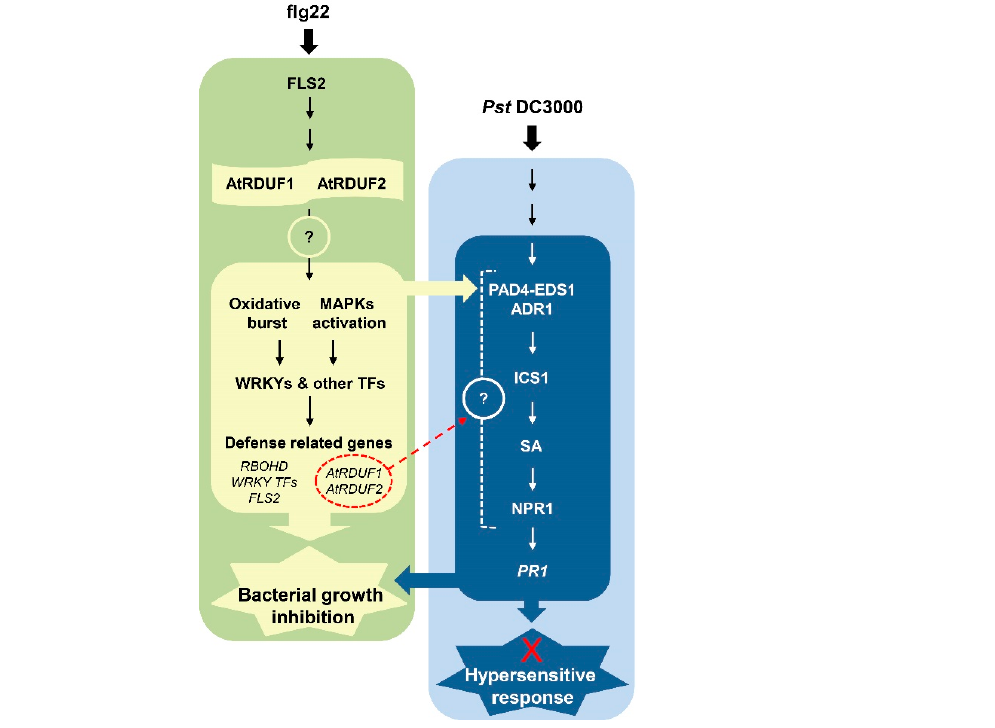
Figure 5. AtRDUF1 and AtRDUF2 are positive regulators of pathogen-associated molecular pattern- triggered immunity (PTI). Recognition of flg22 or pathogens activates AtRDUF1 and AtRDUF2 to amplify flg22-triggered immune responses by removing putative target proteins (question mark in the yellow green circle). At a later time point, activated early flg22-triggered immune responses support ICS1 mediated production of salicylic acid (SA), which leads to the activation of plant immune signaling [54]. During activated SA signaling, AtRDUF1 and AtRDUF2 activate PR1 expression by interacting with a putative target protein (question marked in blue circles). Knockout mutants of AtrDUF1 or AtRDUF2 showed enhanced susceptibility to Pst DC3000. AtRDUF1 and AtRDUF2 are involved in SA-mediated PR1 expression but have no effect on cell death. The pathogen-induced expression of AtRDUF1 and AtRDUF2 does not involve the known defense signaling components ICS1, PAD4, and NPR1. TFs, transcription